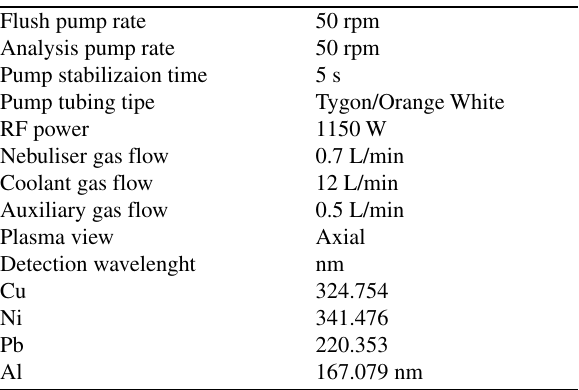
Table 2. Operational ICP-OES parameters Flush pump rate